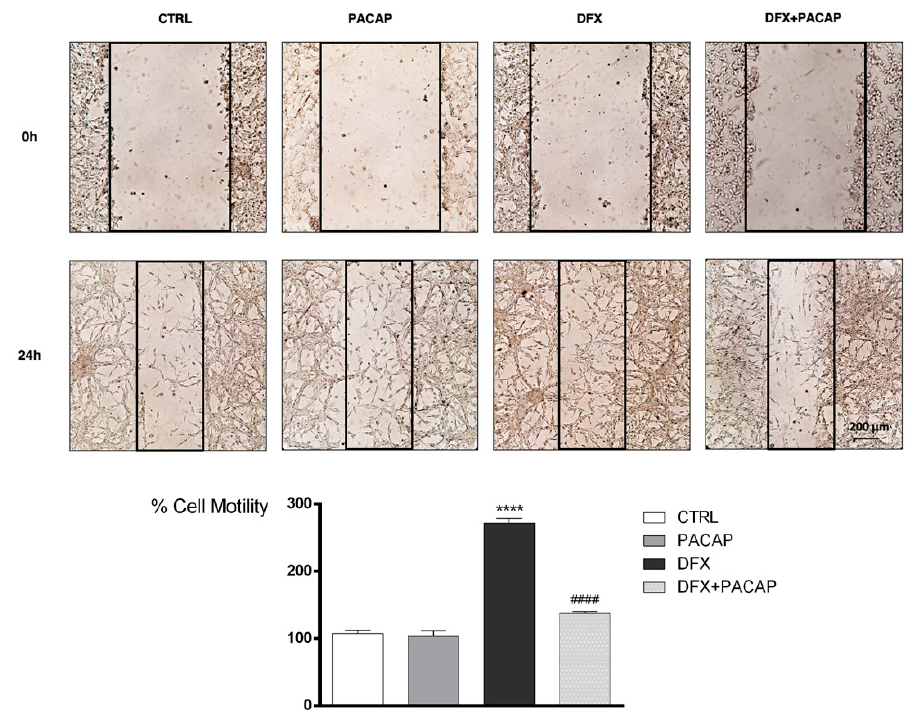
Figure 7. PACAP effect on GBM cells migration following DFX-induced hypoxic insult. Cell mono-layer was scraped by a pipette. The wounded areas were visualized under a microscope for quantification. Migration was calculated as the average number of cells observed in five random wounded fields per well in duplicate wells. In the bar graph, values are expressed as percentage of control. **** p < 0.0001 vs. CTRL; #### p < 0.0001 vs. DFX.